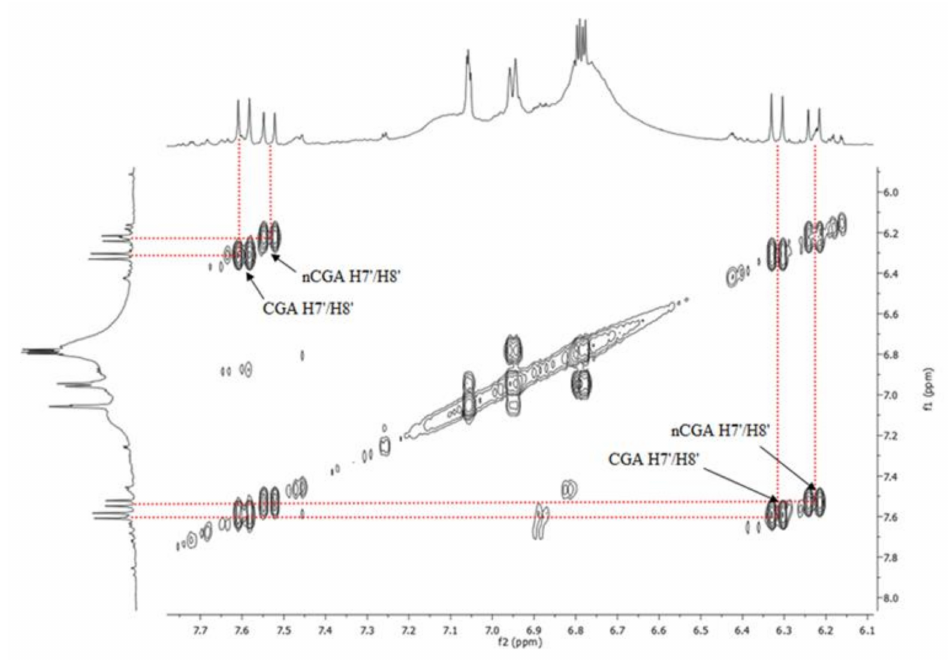
Figure 2. 1 H-NMR spectra of the mix chlorogenic acid and neochlorogenic acid ( a ) and for green fruit extract ( b ) with diagnostic signals, H5 (cid:48) , H2 (cid:48) , H7 (cid:48) , and H8 (cid:48) , respectively.